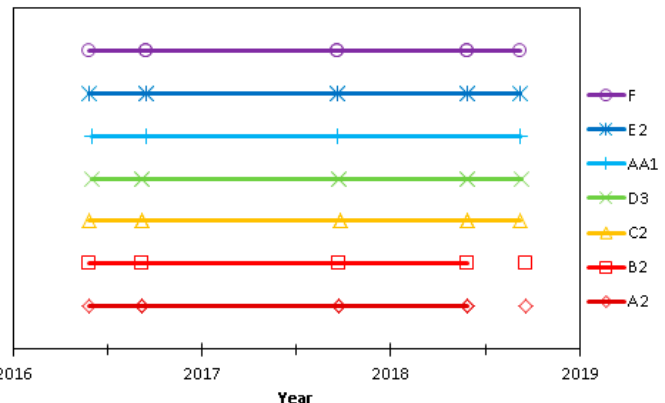
Figure 9. The available observations for 7 stakes along the central flow line, May 2016–Sep. 2018. Different colors denote different stakes. Each mark corresponds to a specific measurement, and each line between two marks indicates that the velocity during that period could be acquired from the difference between the first and second coordinates at the stakes.